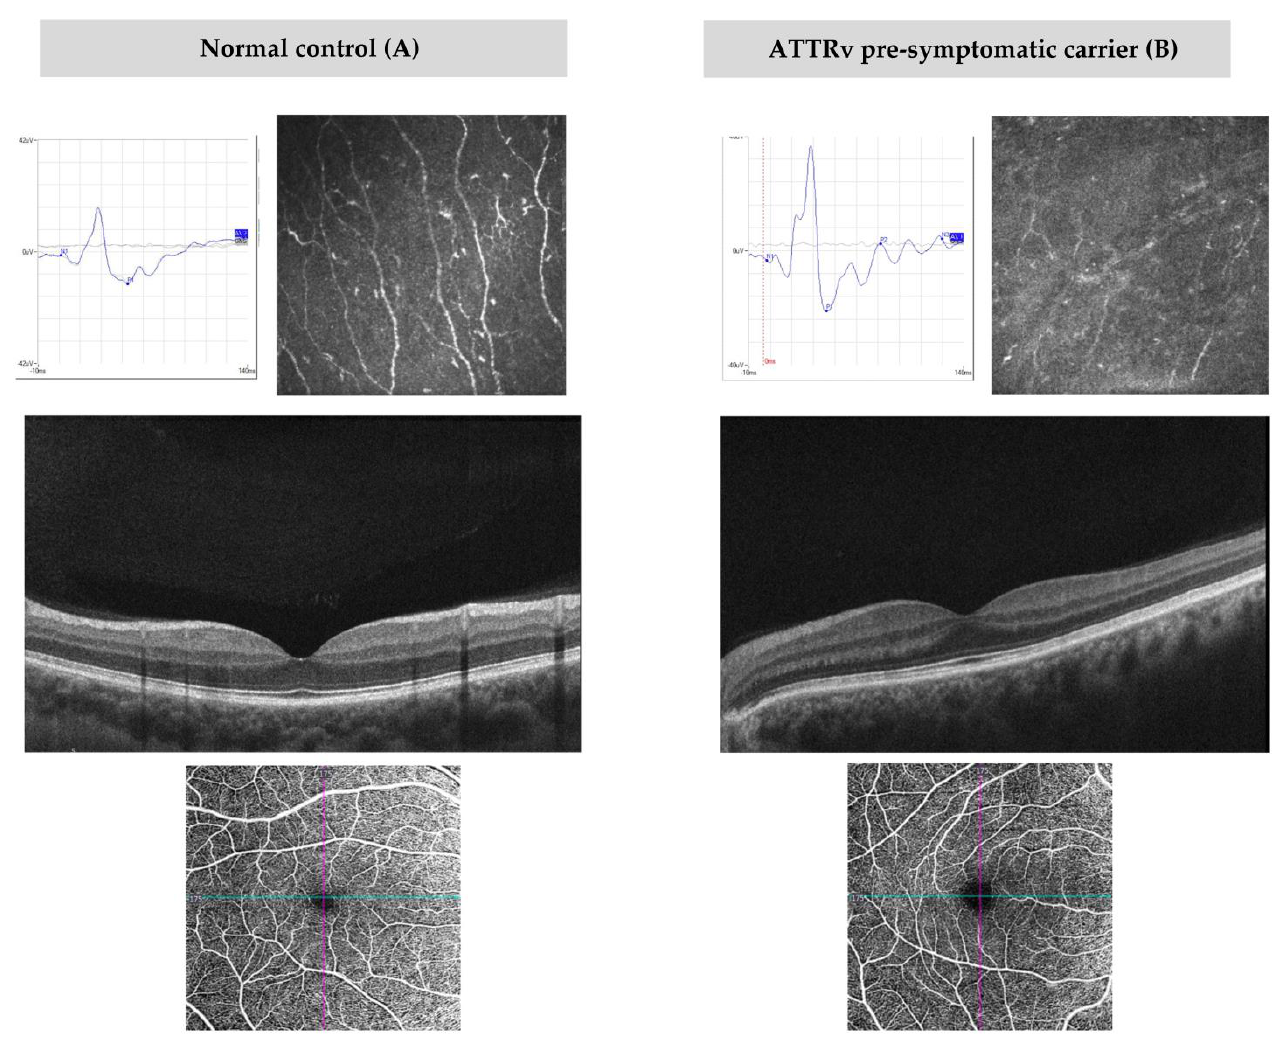
Figure 1. Top to bottom: photopic electroretinogram (ERG), in vivo corneal confocal microscopy (IVCM), OCT B scan and OCT-A images of the superficial capillary plexus (SCP) of normal controls ( A ) and pre-symptomatic ATTRv carriers ( B ). ( A ) shows normal PhNR values (10.52 mV), as well as normal nervous corneal plexus. OCT B scan reveals preserved morphology and reflectivity of all retinal layers, with a mean ONL thickness of 79 microns. OCT-A enface images of the SCP reveal a vessel density of 19.8 mm/mm 2 . ( B ) shows supernormal PhNR (18.52 mV), with an altered corneal nervous plexus. No alterations in retinal morphology and reflectivity are observed on OCT scan. Mean ONL thickness is 61 microns and VD SCP is 17 mm/mm 2